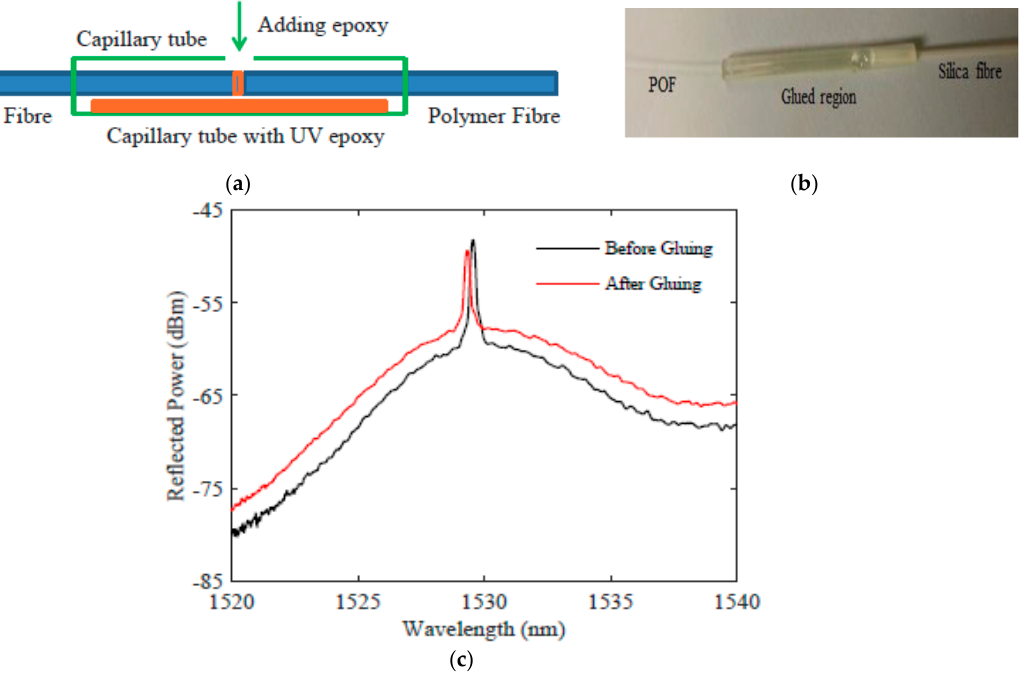
Figure 2. Polymer fibre Bragg gratings (PFBG) pigtail fabrication. ( a ) Schematic of the procedure; ( b ) the glued region of a PFBG pigtail; ( c ) response showing the impact of the epoxy on the PFBG reflection spectrum. POF: polymer optical fibre.